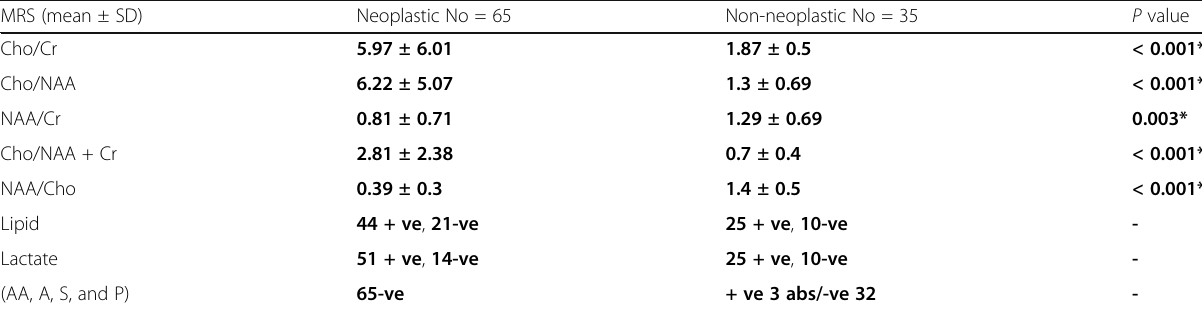
Table 3 Spectroscopic data analysis for all non-neoplastic and neoplastic lesions